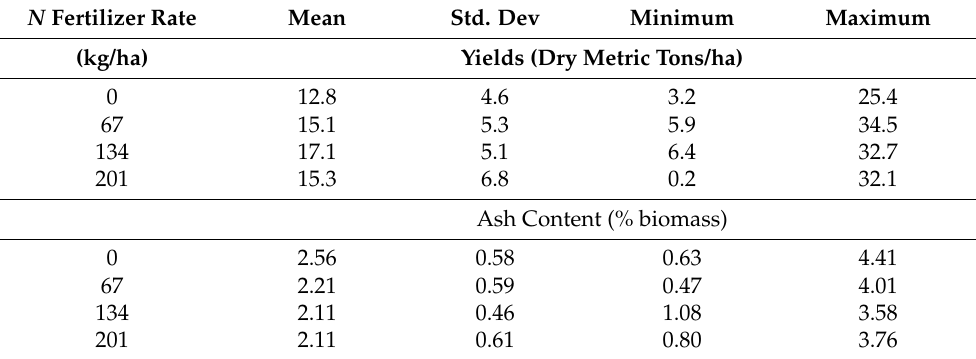
Table 1. Descriptive statistics for Alamo switchgrass yield and ash content when varying nitrogen fertilizer application.